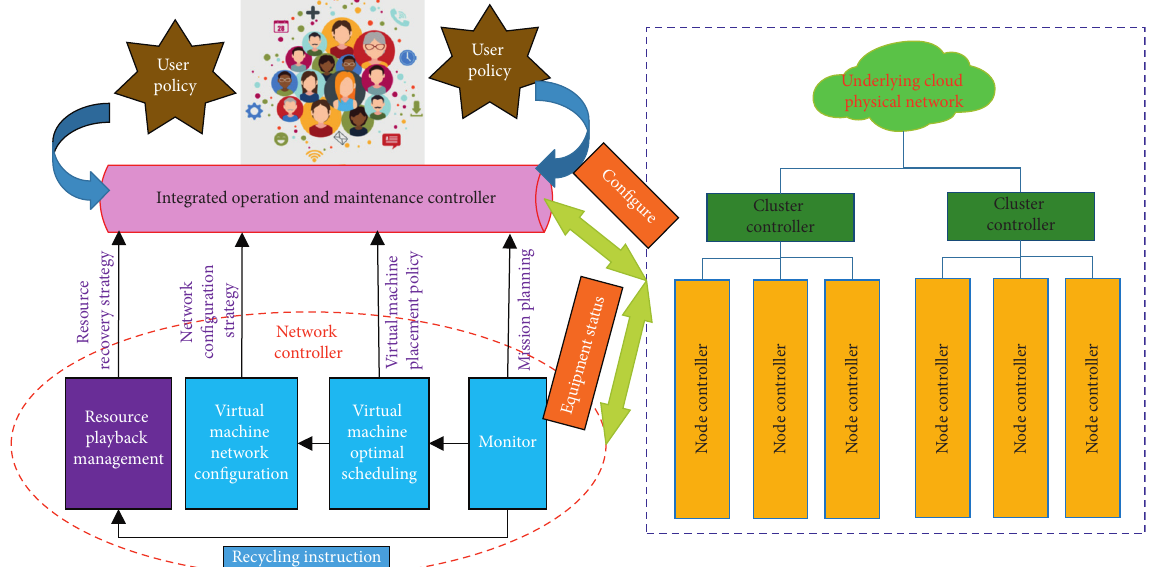
Figure 1: Task-oriented integrated operation and maintenance management